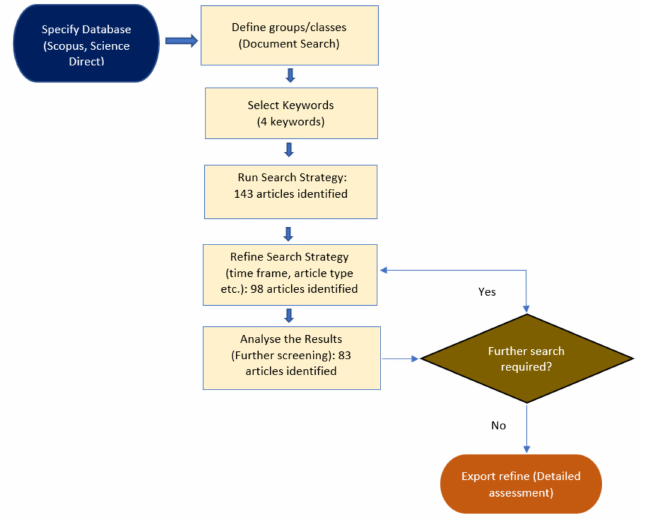
Figure 1. Flow chart of review